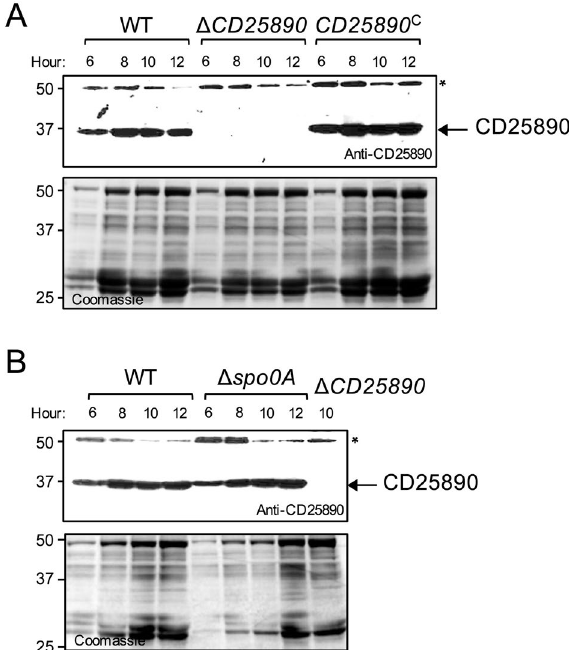
Figure 3. Accumulation of CD25890 during growth. The wild type strain (WT), the (cid:31) CD25890 mutant, the complementation strain ( CD25890 C ) ( A ) and the spo0A mutant ( B ) were grown in SM and samples were collected at 6, 8, 10 and 12 h after inoculation for western blot analysis using anti-CD25890 antibody (* cross- reactive species). The position of molecular weight markers (in kDa) is indicated on the left side of the